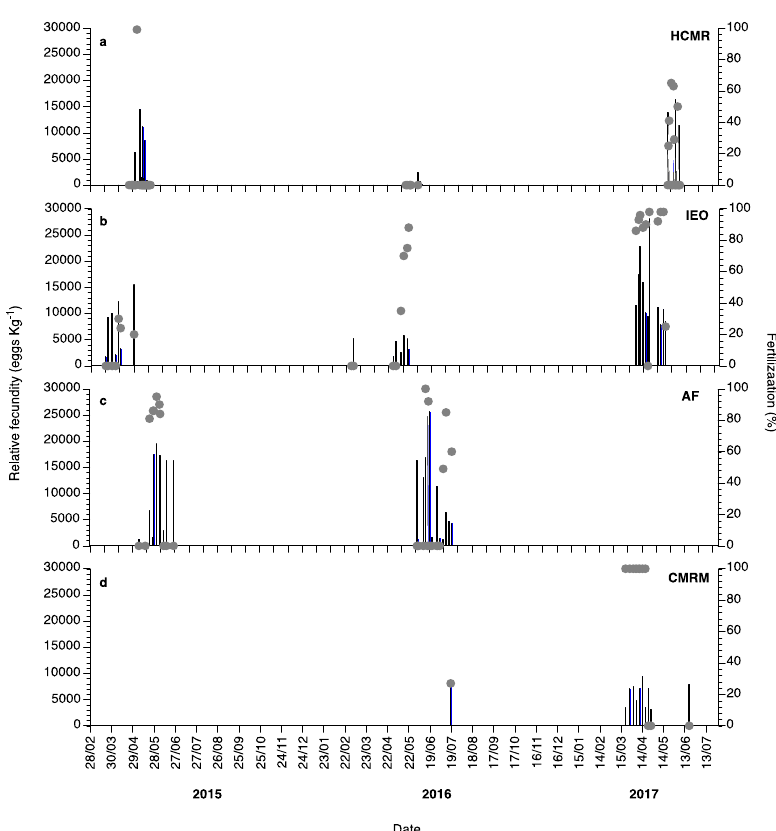
Figure 10. Mean relative fecundity (black bars) and fertilization (%, grey circles) of the spontaneous spawns of wreckfish broodstocks obtained at HCMR ( a ), Instituto Español de Oceanografía (IEO) ( b ), Aquarium Finisterrae (AF) ( c ) and Conselleria do Medio Rural e Mariño (CMRM) ( d ) during 2015, 2016 and 2017.